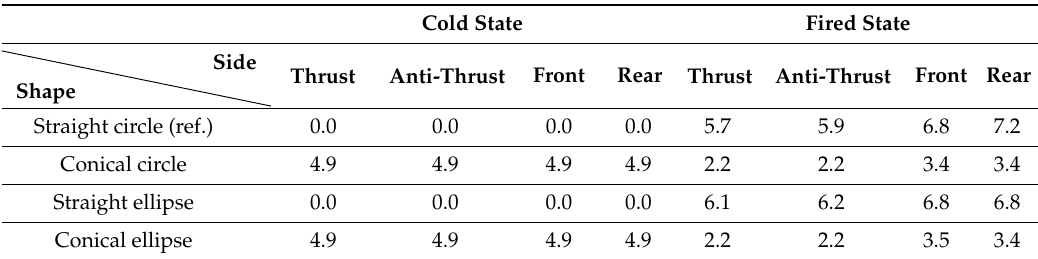
Table 3. Straightness deviation for the liner in both the cold state and under typical fired operational conditions. (Numbers are given in micrometers). Cold State